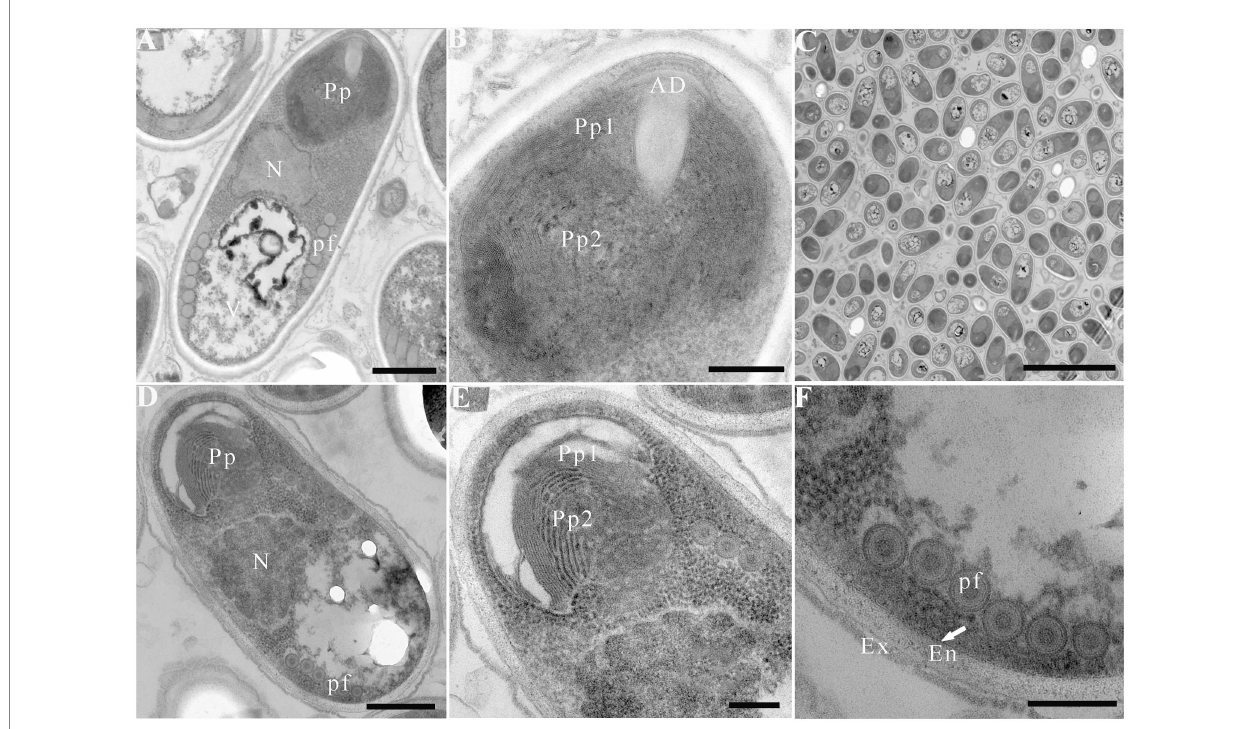
FIGURE 4 Electron microscopy of Pseudokabatana alburnus isolated from different fish. (A–C) Mature spore isolated from Toxabramis swinhonis , (D–F) Mature spore isolated from Hemiculter leucisculus. (A) A mature spore of P. alburnus isolated from T. swinhonis with typical microsporidian features of internal structure, including a mushroom-shaped anchoring disk, a bipartite polaroplast (Pp), a large nucleus (N), a large vacuole (V), the isofilar polar filaments (pf) and a trilaminar spore wall. Scale bar = 500 nm. (B) Magnification of the bipartite polaroplast showing narrow lamellae (Pp1) and wide lamellae (Pp2), a mushroom-shaped anchoring disc (AD) locating in the apex of spore. Scale bar = 200 nm. (C) Mature spores occur in direct contact with the host cell cytoplasm. Scale bar = 5 μ m. (D) A mature spore of P. alburnus isolated from H. leucisculus with bipartite polaroplast (Pp) and the isofilar polar filaments (pf). Scale bar = 500 nm. (E) Magnification of bipartite polaroplast (Pp1, Pp2). Scale bar = 200 nm. (F) Magnification of trilaminar spores wall showing an electron-dense exospore (Ex), an electron-translucent endospore (En) and a plasma membrane (arrow). Scale bar = 200